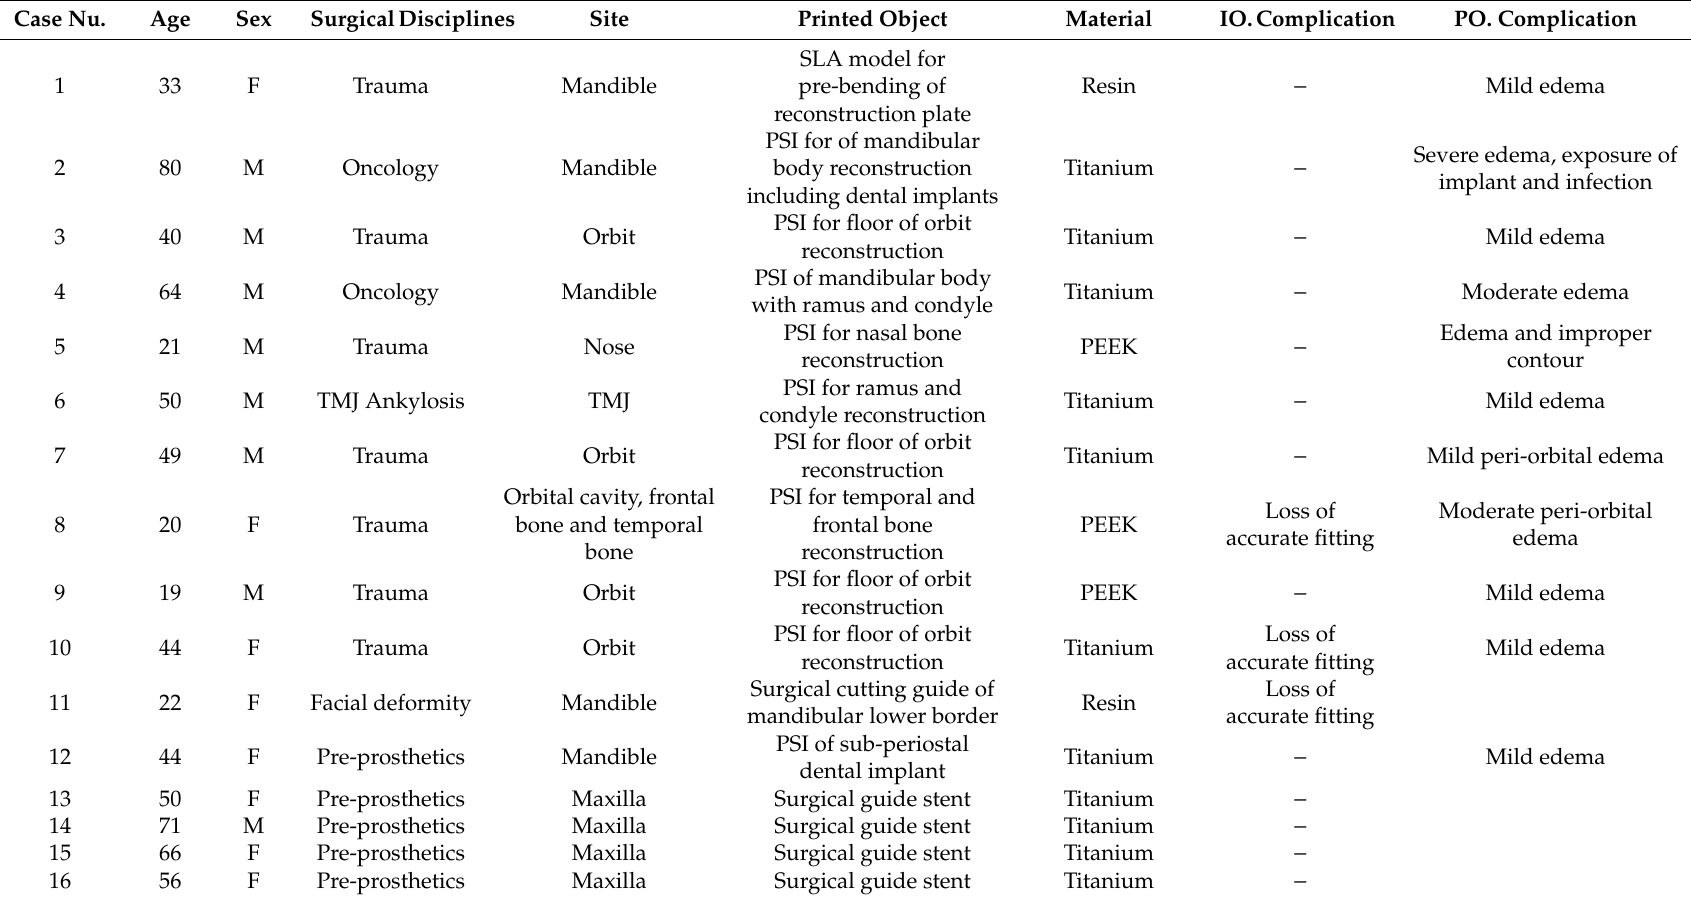
Table 1. List of the 16 cases that were treated at our department between 2015–2020 using the 3D technology including demographic data, surgical discipline, site of surgery, the printed objects, material of choice, intra-operative and post-operative complications. IO: intra-operative, PO: post-operative, TMJ: temporomandibular joint. PEEK: polyetheretherketone, PSI: patient-specific implant, SLA: stereolithographic. Case